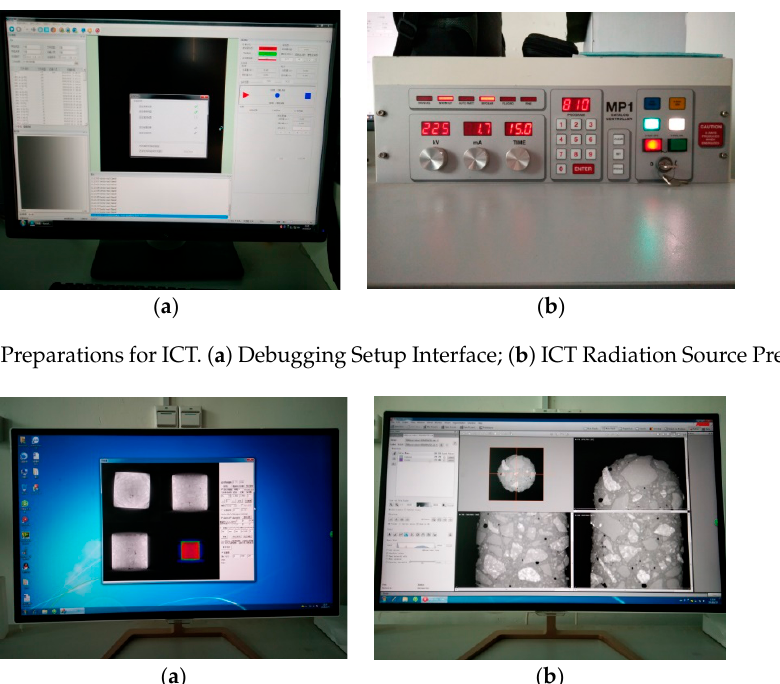
Figure 5. Preliminary Data Processing. ( a ) Data Pre-processing Interface; ( b ) Avizo Data Post-Processing Interface.